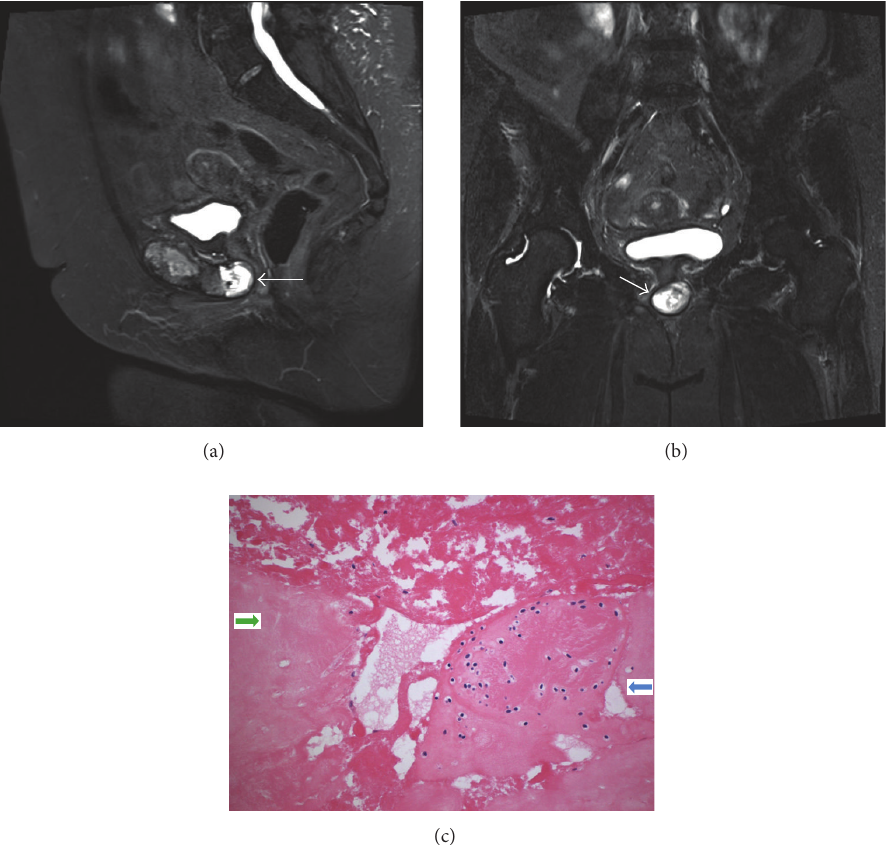
Figure 2: Case 2. A 56-year-old, postmenopausal, lady, presented with voiding dysfunction. Examination revealed painless smooth, rounded, firm, and cystic mass, at the anterior vaginal wall of about 4cm width related to the pubic symphysis. (a) Sagittal T2-weighted image of a well delineatedhyperintensepseudocyst,relatedtothepubicsymphysis.(b)CoronalT2-weightedimageofthepseudocyst.(c)Thehistopathologic features of the cyst. The 200x image shows an area of vital hyaline cartilage (blue arrow) with fibrinous degeneration of its centre. The cartilage is surrounded by partly cystic fibrous substance. The green arrow points to part of a necrotic